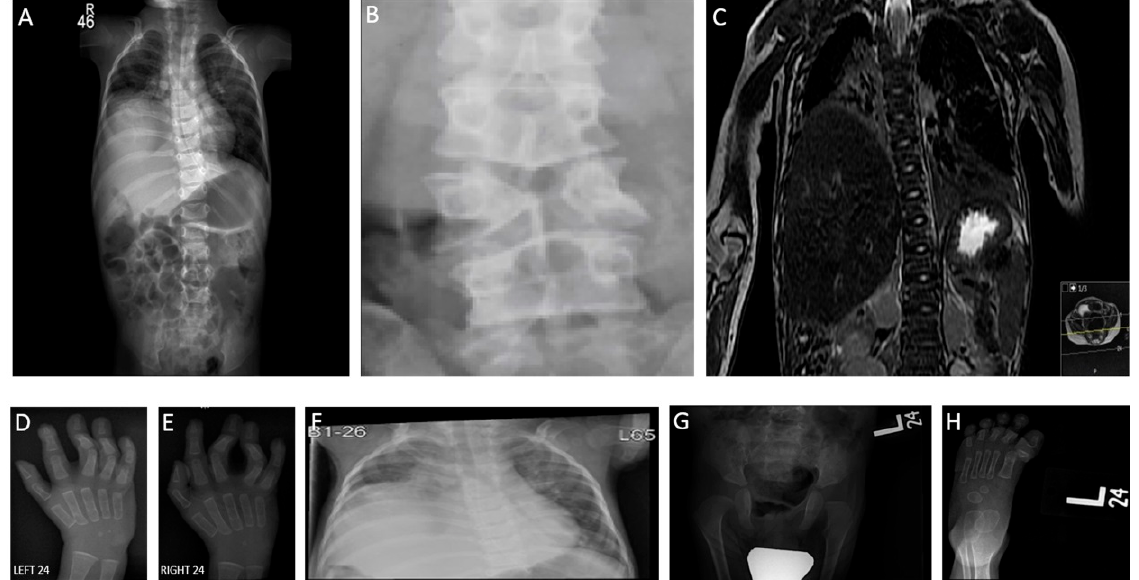
Figure 3. Radiological demonstration of deformities in patient 1. ( A ) Mild right convex scoliosis in the dorsal spine. ( B ) Butterfly vertebrae in the dorsal and lumber vertebra. ( C ) Mild right convex scoliosis in the dorsal spine. ( D, E ) Flexion deformity in the fingers especially the ring and middle fingers of both hands involve the proximal interphalangeal joints. ( F ) Elevation of the right hemidiaphragm is noted with atelectasis in the right lower lobe and bronchiectasis in both lower lobes. Heart size is normal ( G ) Subluxation of the left hip joint. ( H ) Hypoplasia of the proximal phalanx of the left big toe with subluxation of the first metatarsophalangeal joint on the left side. Very small muscles in both lower limbs. Bilateral geno valgum more on the left side with flexion of the left knee joint.